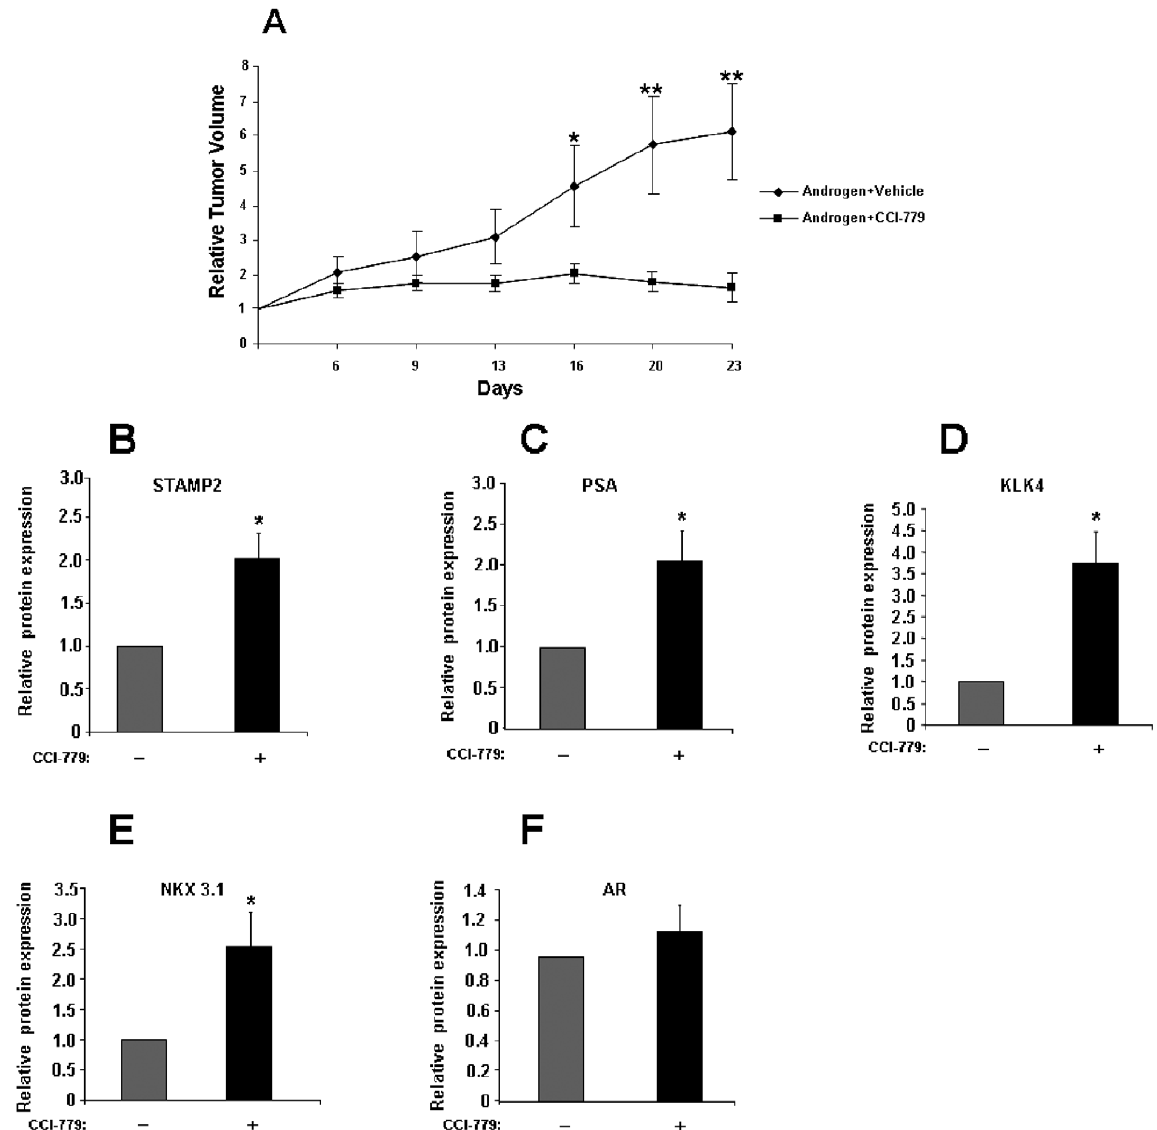
Fig. 6. mTOR inhibition represses the growth of CWR22 xenografts. (A) Relative tumor volume of CWR22 xenografts treated with androgen and CCI-779. CWR22 xenografts were grown in nude mice as described in Section 2 and were treated with testosterone (Tes) plus vehicle (triangles) or testosterone plus CCI-779 (squares). Mice were treated for five days per week for three consecutive weeks. Relative tumor volumes (RTV) were set as 1 for each individual tumor at the start of the treatment, day 0, with ± SEM indicated as error bars. The significance between the two groups was calculated by one-tailed, unpaired Student’s t -test; single asterisk: P < 0 . 05; double asterisk: P < 0 . 01, n = 5–8 per sample. (B–E) Expression analysis of AR target genes in CWR22 xenografts treated with testosterone (Tes) and CCI-779. Total protein was extracted and the expression of STAMP2 (B), KLK4 (C), NKX3.1 (D), PSA (E) and AR (F) was investigated by Western blotting, normalized to GAPDH or tubulin, and quantified. The expression values are relative to cells that were treated only with testosterone (set to 1), with ± SEM indicated as error bars. The significance between the two groups was calculated by one-tailed, unpaired Student’s t -test; asterisk: P < 0 . 05; n = 4–7 individual